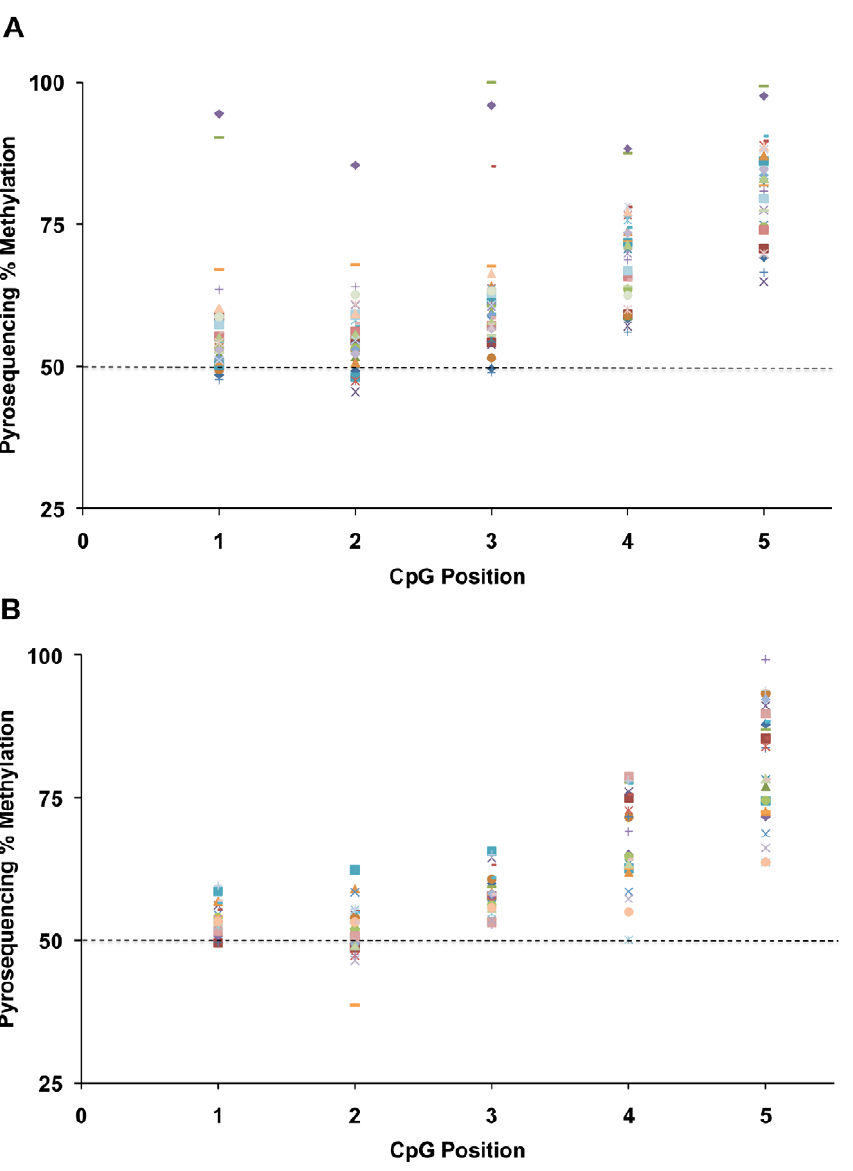
Figure 2. Pyrosequencing methylation at the IGF2/H19 DMR in placenta. (A) 31 in vivo individuals, and (B) 26 in vitro individuals. The methylation results at each CpG site for each individual are represented by a horizontal series of symbols. All but a few of the CpGs show methylation levels of 50% or higher, which is in concordance with our findings of gain of methylation on the maternal allele (M/P $ 0.15 in placenta, Figure 1).